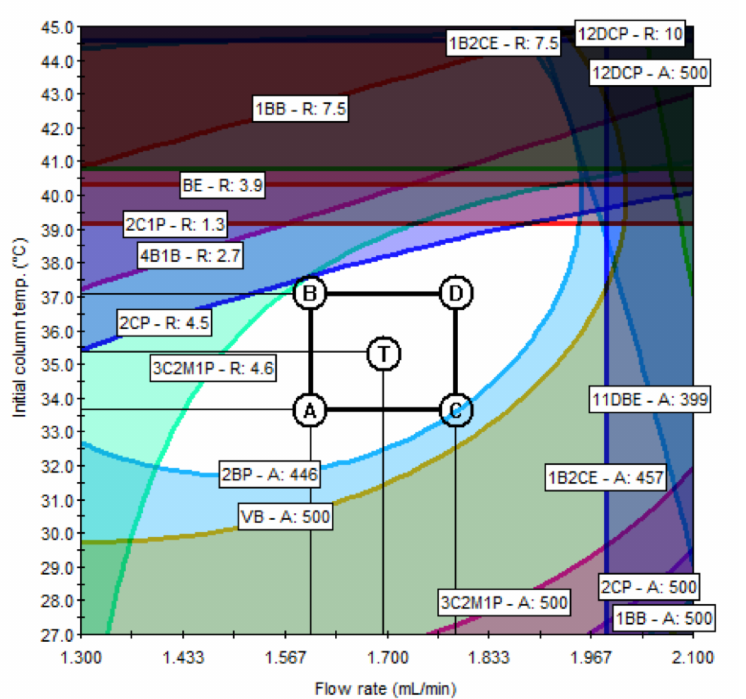
Figure 6. Method operable design region (MODR) and proven acceptable ranges (PARs) for method A.